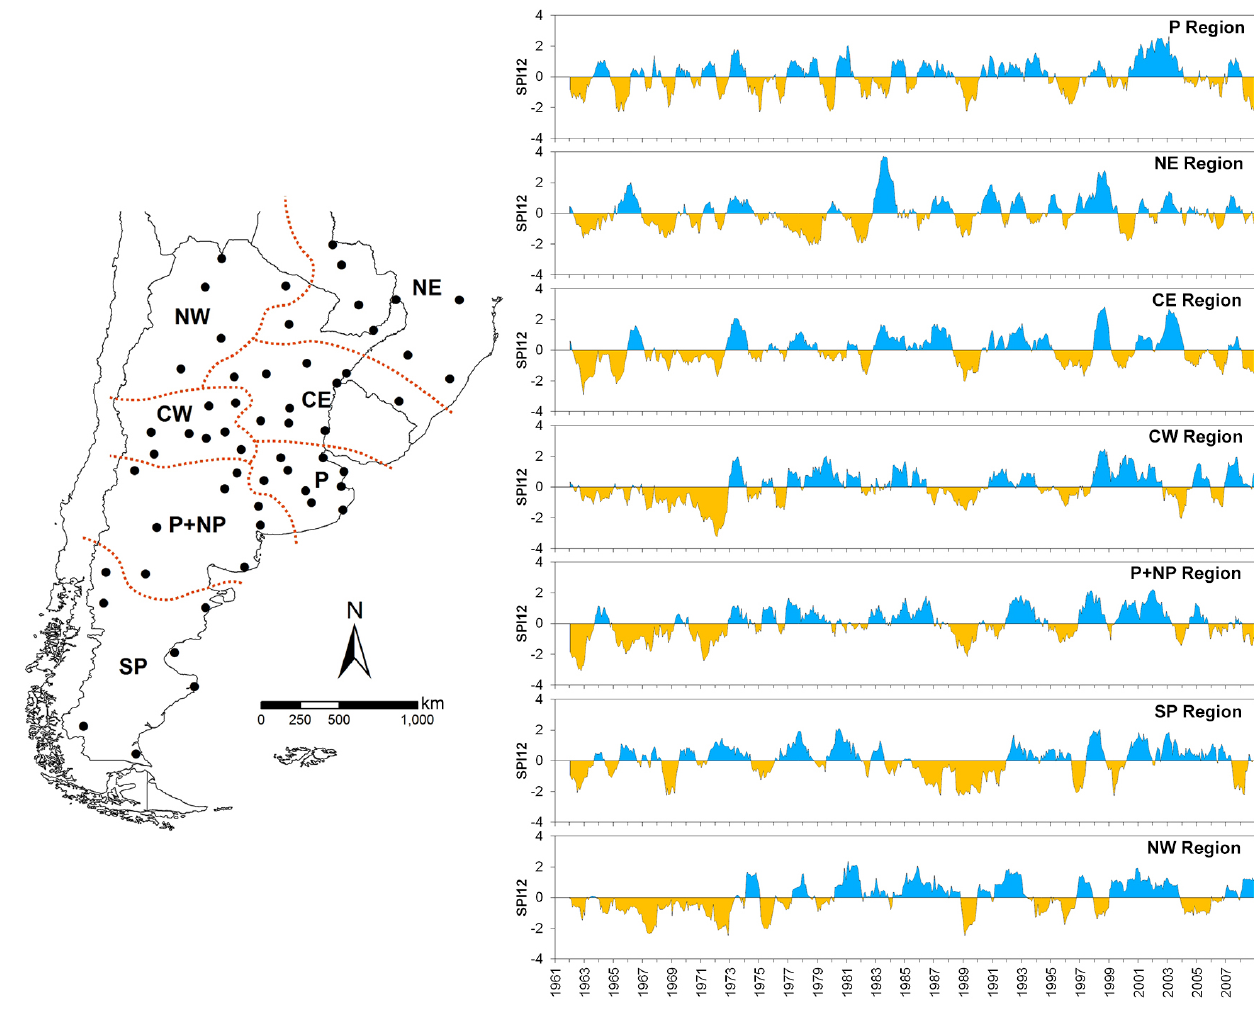
Figure 5. Same as Fig. 3 for the SPI12 time